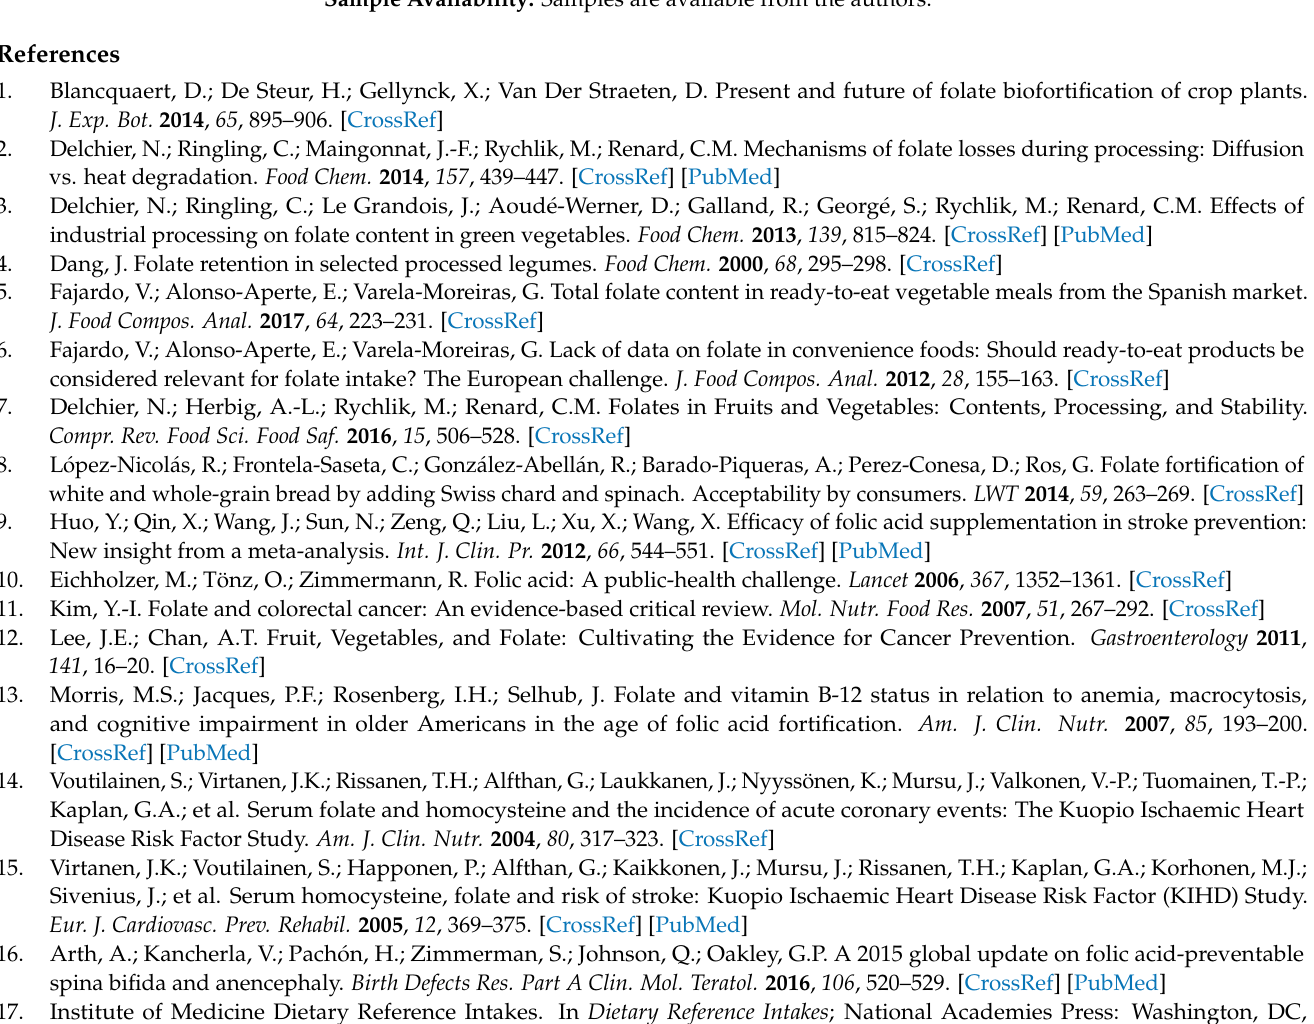
Supplementary Materials: The following are available online. Figure S1. HPLC-UV chromatogram (290 nm) of folate derivatives—standard mixture. Figure S2. HPLC-FLD chromatogram (ex. 290 nm, em. 360 nm) of folate derivatives—standard mixture. Figure S3. HPLC-FLD chromatogram (ex. 360 nm, em. 460 nm) of folate derivatives-standard mixture. Figure S4. HPLC-FLD chromatogram (ex. 290 nm, em. 360 nm) of folate derivatives—organic egg sample. Figure S5. HPLC-FLD chromatogram (ex. 360 nm, em. 460 nm) of folate derivatives—organic egg